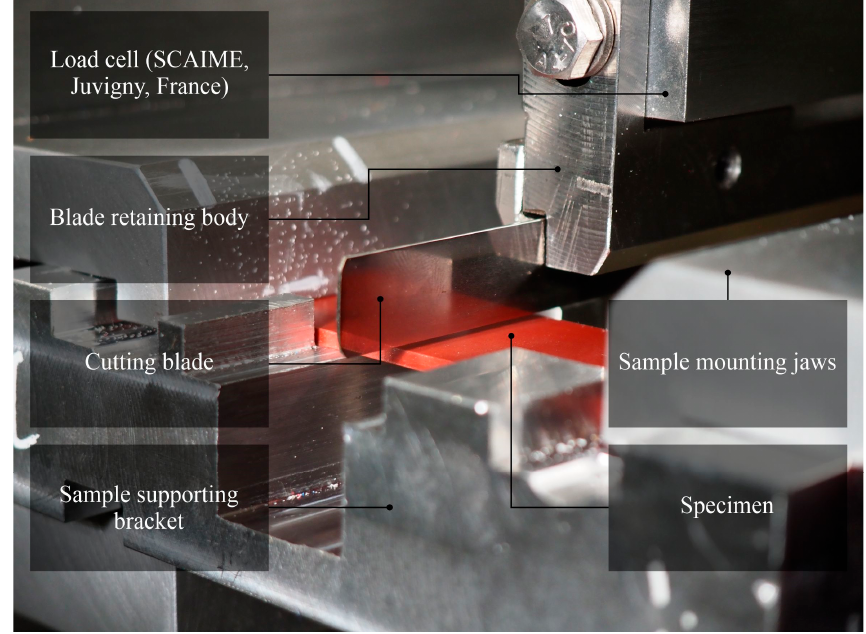
Figure 5. Sample mounted in jaws and supporting bracket during cutting test.